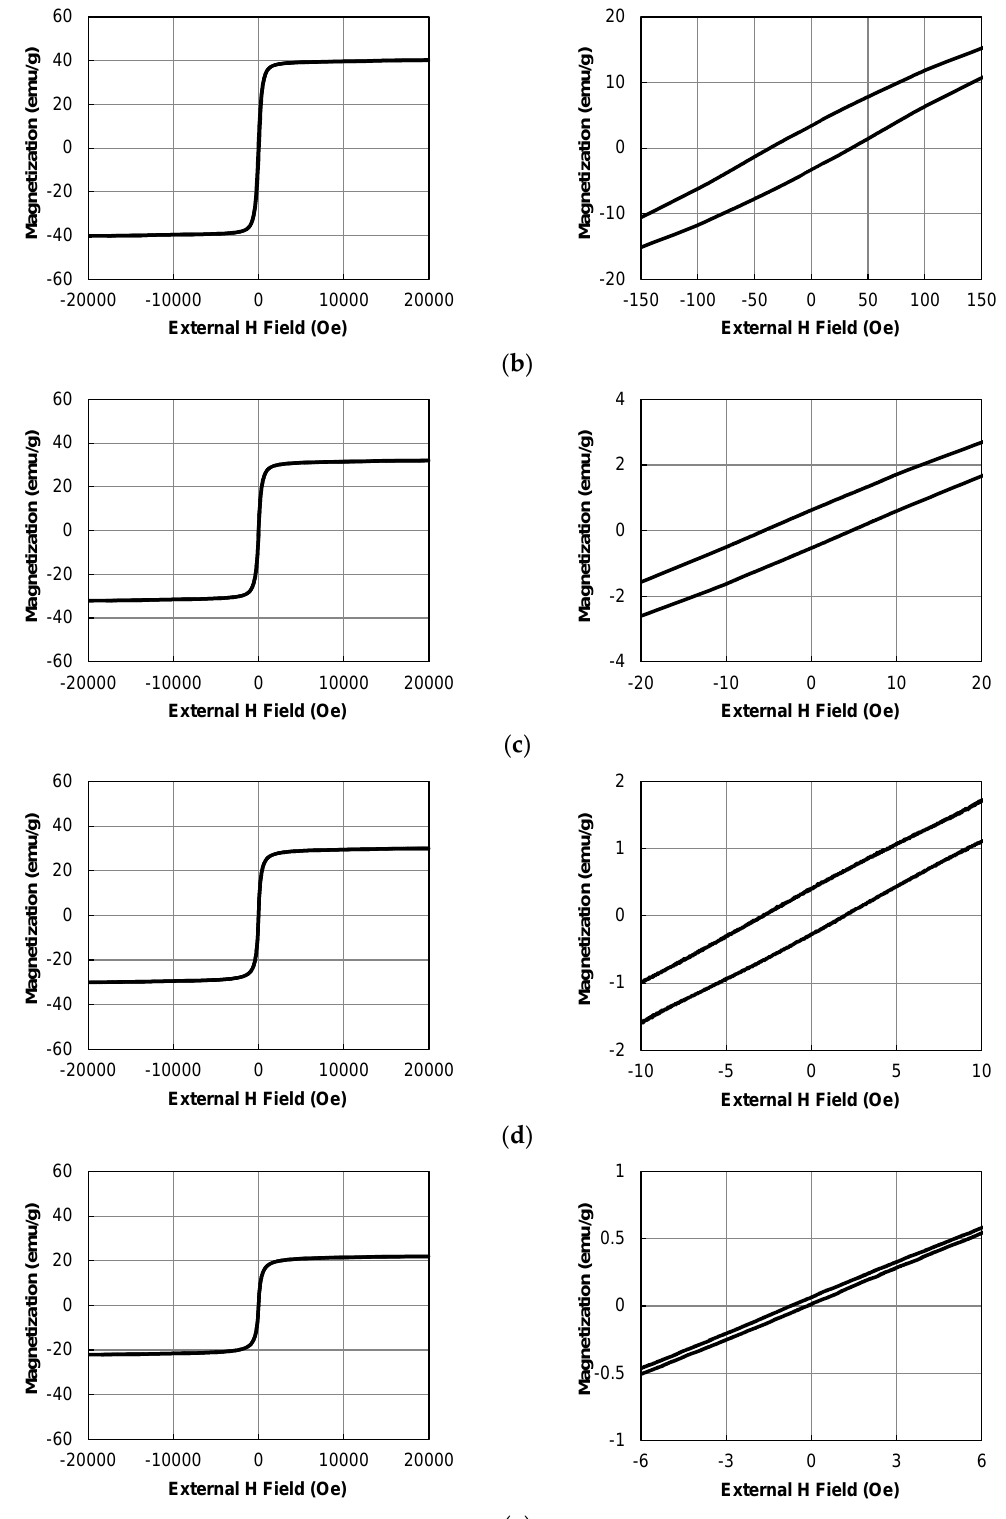
Figure 6. Magnetization curves of the Ni nanoparticles, entire ( left ) and enlarged views ( right ), at the TOP/Ni ratios of ( a ) 0, ( b ) 0.1, ( c ) 0.3, ( d ) 0.5, and ( e ) 0.8.